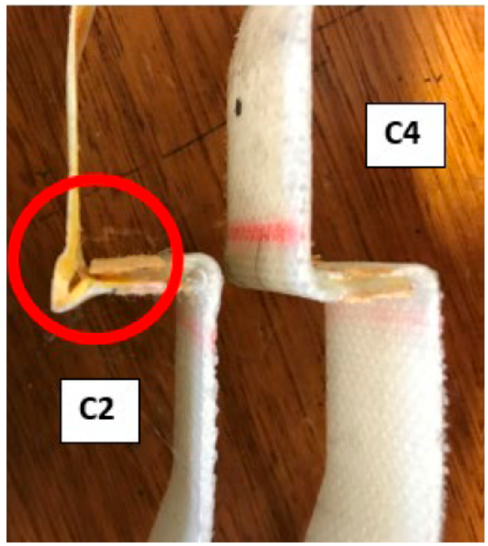
Figure 8. Comparison of a defective 90° joint (left) with a healthy 90° joint (right) showing no sign of defects.